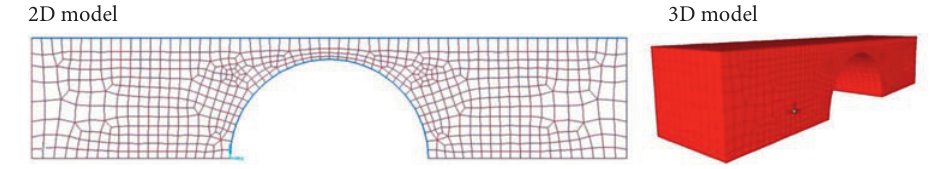
Fig. 5. Underpass PA1 – finite